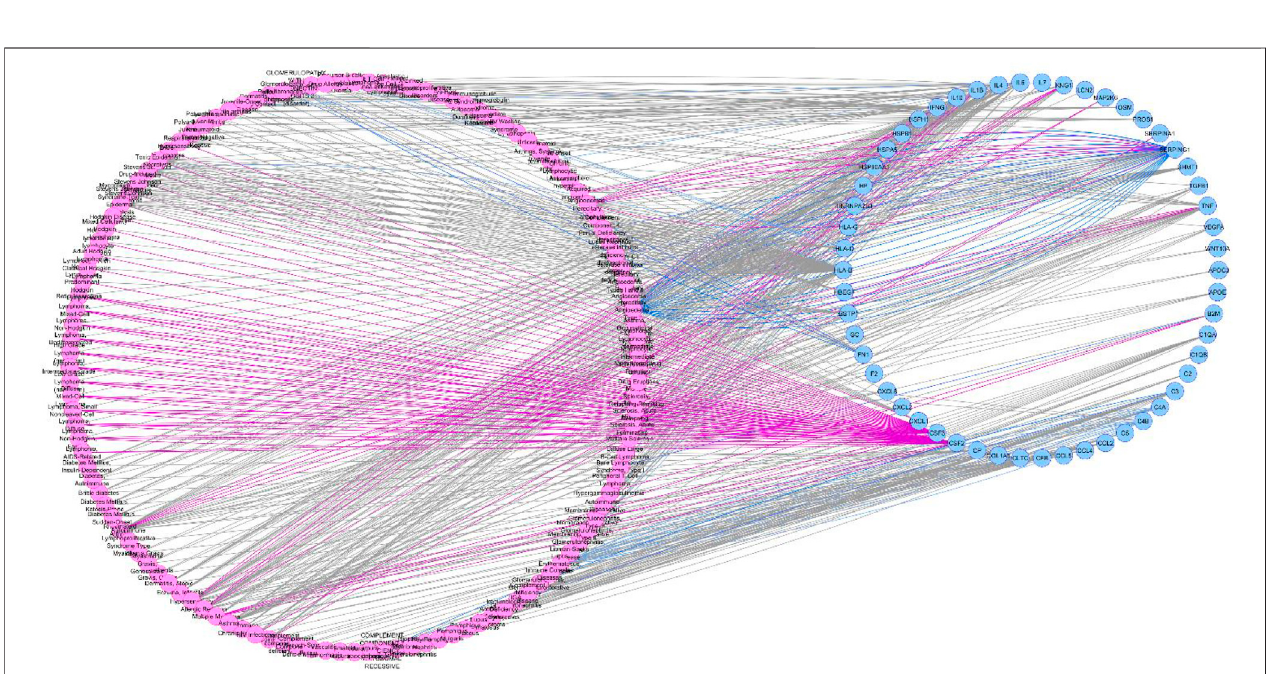
FIGURE 2 | Curated diseasome network (CURDi). CURDi forms the two node sets of bipartite networks with two types of nodes: diseases (pink circle) and gene (blue circle). Disease node and gene node are connected if the gene is implicated in the disorder.